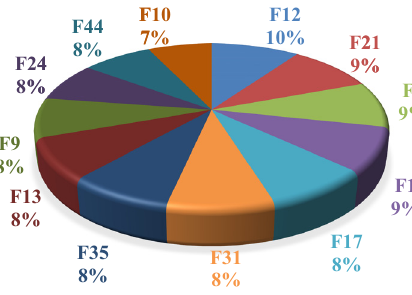
Figure 5: Local impact of factors in the planning stage.